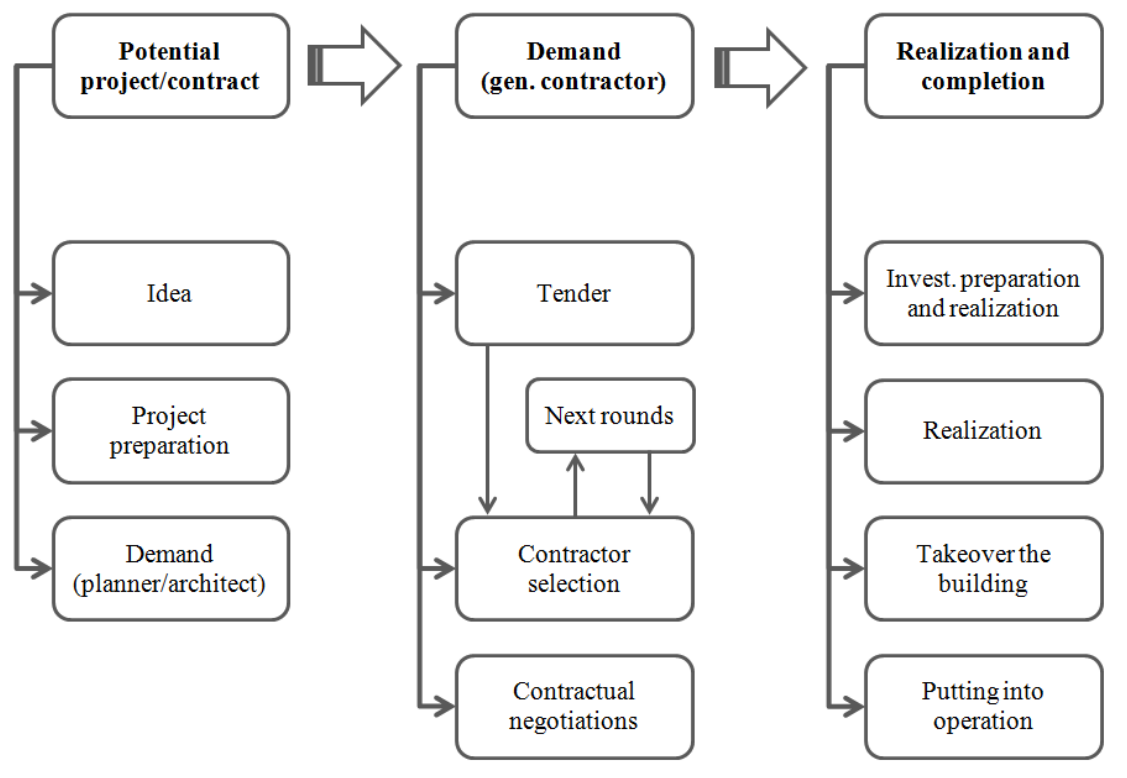
Figure 3: Project management – investor (Source: